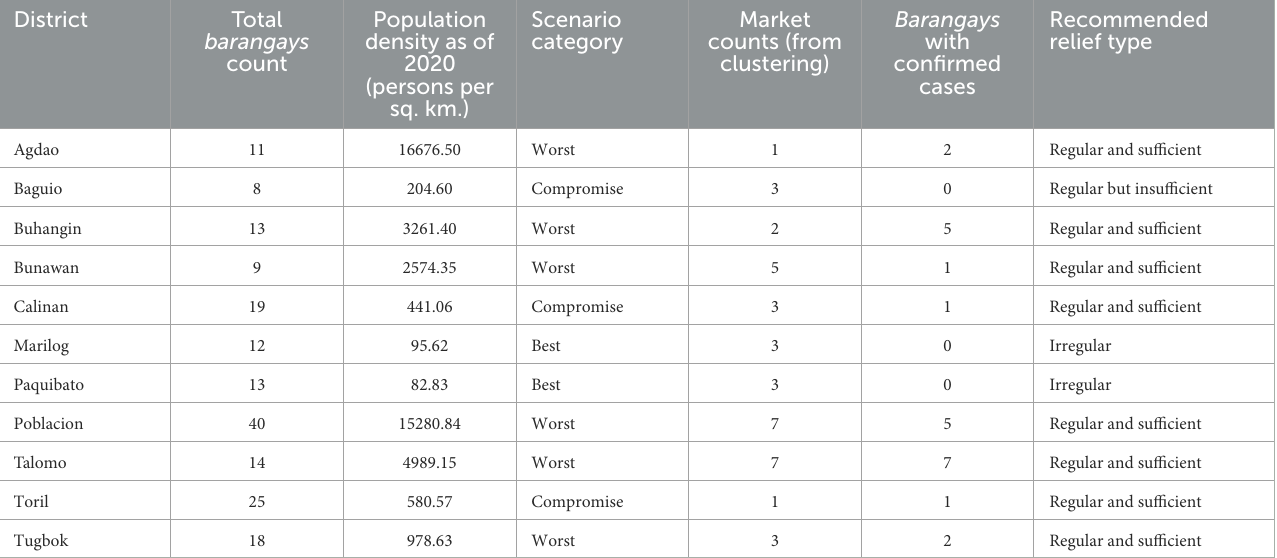
Market Barangays counts (from with clustering) confirmed